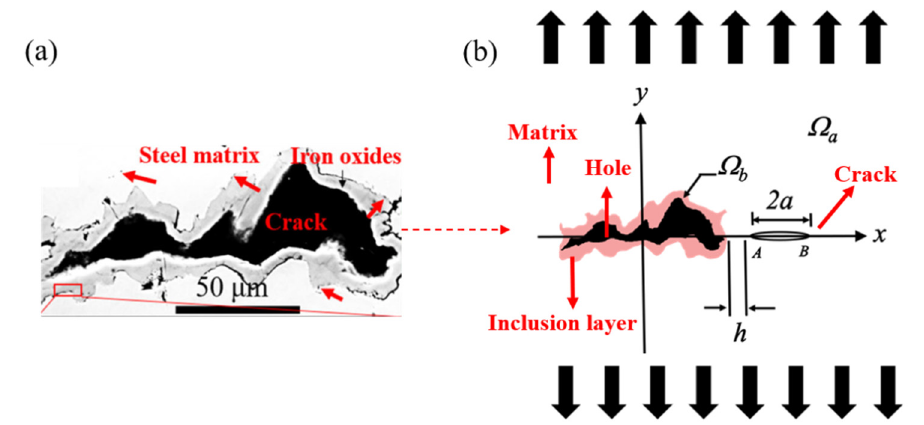
Figure 2. ( a ) Observation of macrostructure of hole, iron oxide, and steel matrix after the process of whole thermal treatment. Reprinted from Ref. [3]; ( b ) outlined photograph for illustrating the interaction between a line crack in the steel matrix and an irregular hole with inclusion layer under an in-plane remote uniform tensile loading.